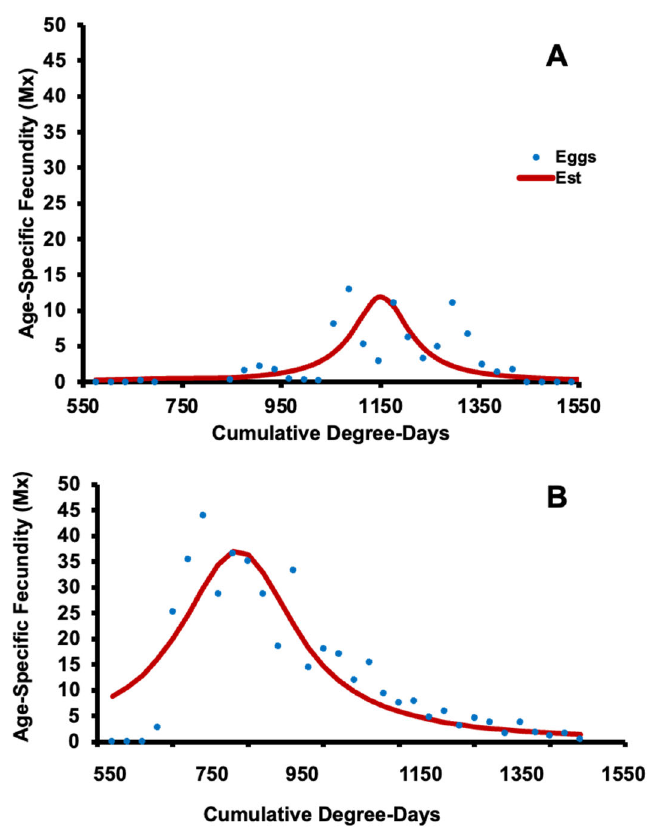
Figure 5. Age-specific fecundity ( M x , blue dots) and Cauchy distribution fit (red line) of Oregon ( A ) and New Jersey ( B ) populations of H. halys over physiological time (degree days).